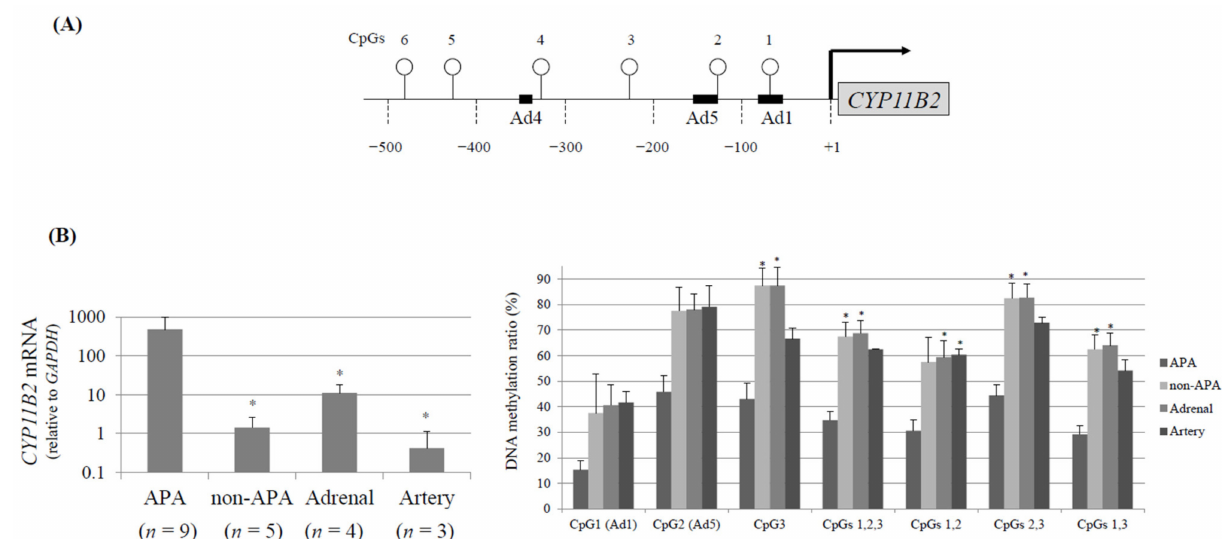
Figure 5. ( A ) Schema of CpG dinucleotides within the human CYP11B2 gene promoter. Open circle denotes CpG dinucleotides. ( B ) Inverse correlation between DNA methylation and CYP11B2 mRNA levels. The CYP11B2 mRNA level was significantly elevated in APA. The CpG methylation ratios of the CYP11B2 promoter was significantly decreased in APA. * p < 0.05 compared to aldosterone-producing adenoma (APA) ( n = 9, APA; n = 5, non-APA; n = 4, the adrenal gland; n = 3, the